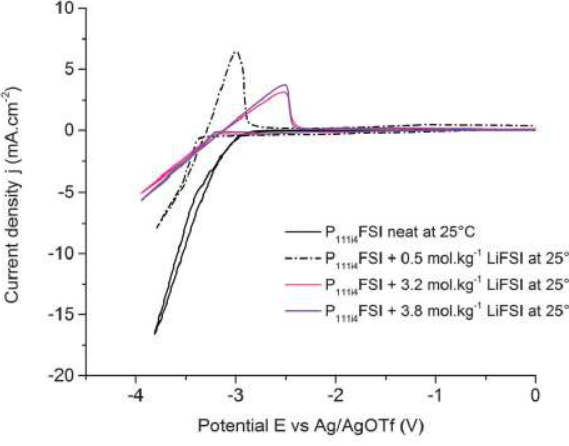
Figure 16. Linear sweep voltammograms (1st cycle) for neat [P 111i4 ][ NTf 2 ] and solutions of 0.5, 3.2